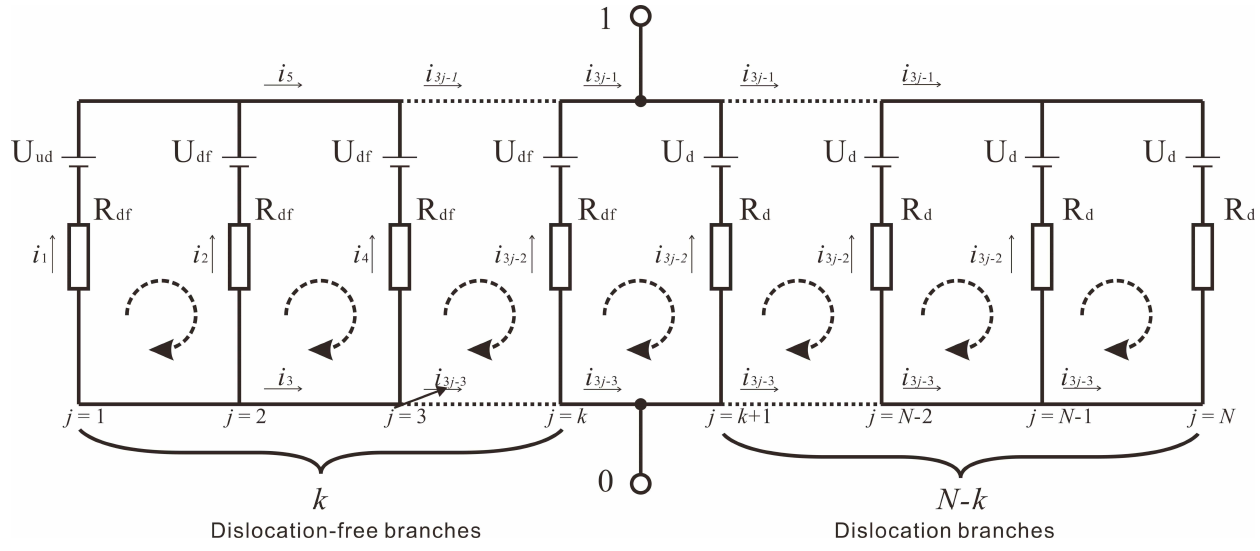
Figure 11. A simplified electrical model for the tip measuring area, U df stands for the voltage difference of dislocation -free branches, U d stands for the voltage difference of dislocation branches. R df stands for the resistance of electrons flowing through the dislocation -free branches, R d stands for the resistance of electrons flowing through the dislocation branches, i stands for the branch current, k stands for the number of dislocation -free branches, N stands for the number of the surface of the grain branches.